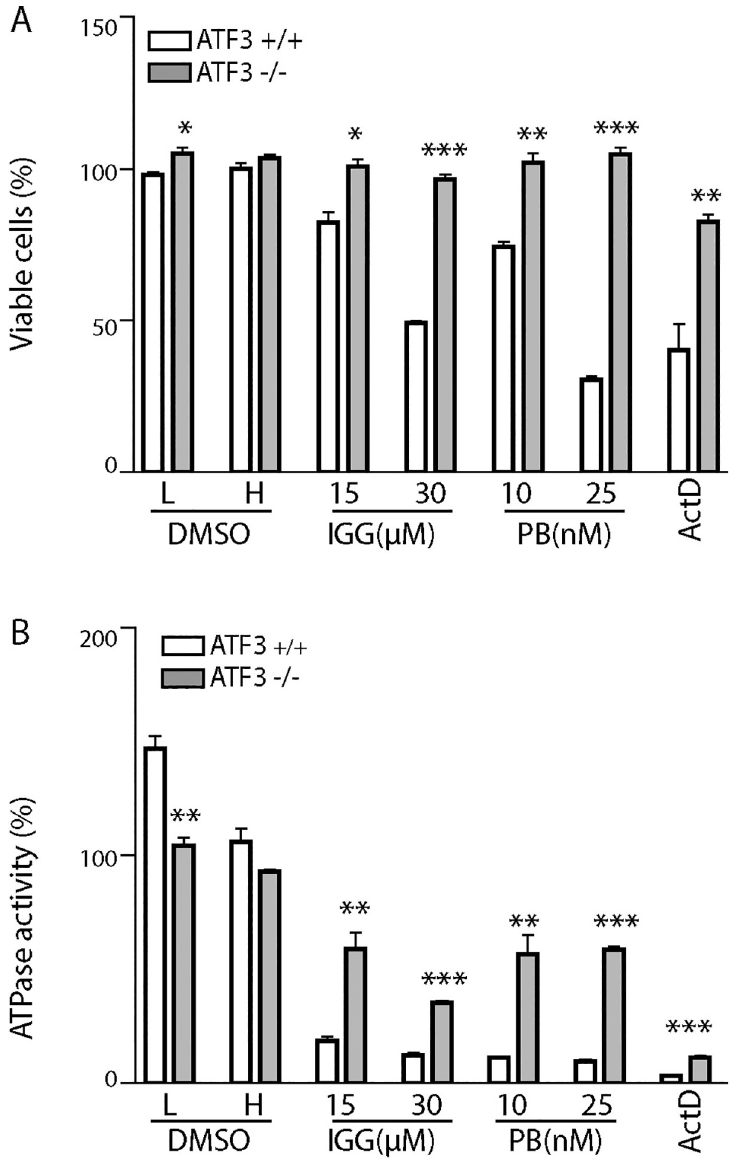
Fig 2. The absence of ATF3 in MEFs increases cell viability following PB and IGG treatment. ATF3 +/+ MEFs (white) and ATF3 -/- MEFs (grey) were incubated with 30 μ M IGG, 25nM PB and 200nM act D for 24h (A) or 48h (B). L and H refer different volumes of DMSO required to serve as vehicle controls for the 2 concentrations of IGG. (A) A trypan blue exclusion assay was used to assess membrane integrity, as an indicator of cell viability. (B) The CellTiter- Glo 1 Luminescent Cell Viability Assay was used to estimate metabolic activity as an indicator of cell viability. Each bar represents the mean of 3 independent experiments, +/- SEM. Statistical significance between cell lines for each treatment was completed using a t-test ( � p < 0.05, �� p < 0.01, ��� p <